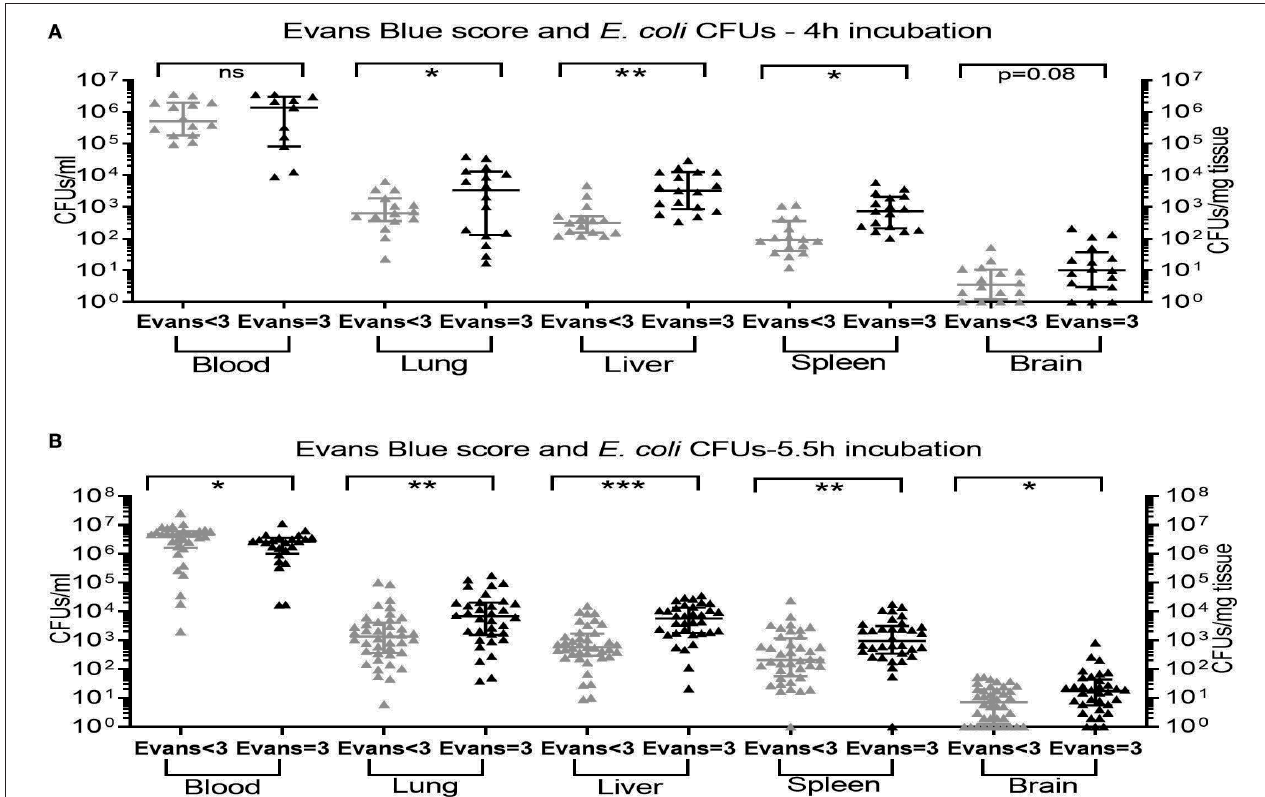
FIGURE 4 | Recovery of E. coli CFUs in organ tissue was associated with a high Evans blue score. Neonatal mice < 24h old were injected IV with E. coli 10 5 CFU/g body weight suspended in saline with 0.05% Evans blue dye. Evans blue injection scores were assigned immediately following IV injections. After (A) 4h ( n = 11–17) and (B) 5.5h ( n = 24–40) of incubation, mice were euthanized and blood and homogenized organ tissue serially plated for bacterial counting. Significant differences of CFU counts for each organ and blood (plotted as median and IQR) derived from animals with low Evans blue score < 3 vs. high Evans blue score = 3 (successful IV injection) were as indicated: * p < 0.05, ** p < 0.01, *** p < 0.001, 2-sided t- tests with Welch’s correction (A) and Mann-Whitney U -tests (B)